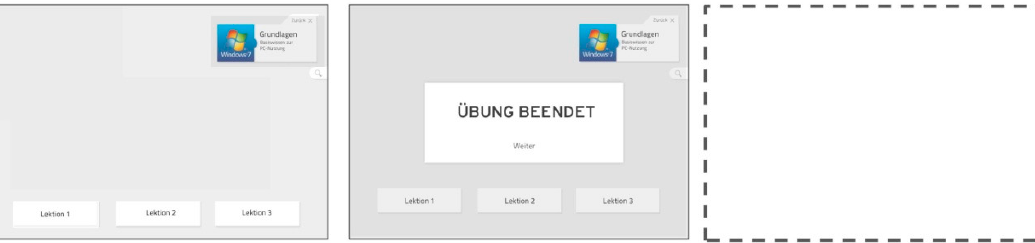
Figure 3. Screenshots of the non-gamified version of the PC trainer. Screenshots are showing the task selection window ( left ) and the feedback pop-up after solving a set of five tasks ( middle ), displaying “end of exercise”. In this version, no personal profile existed.